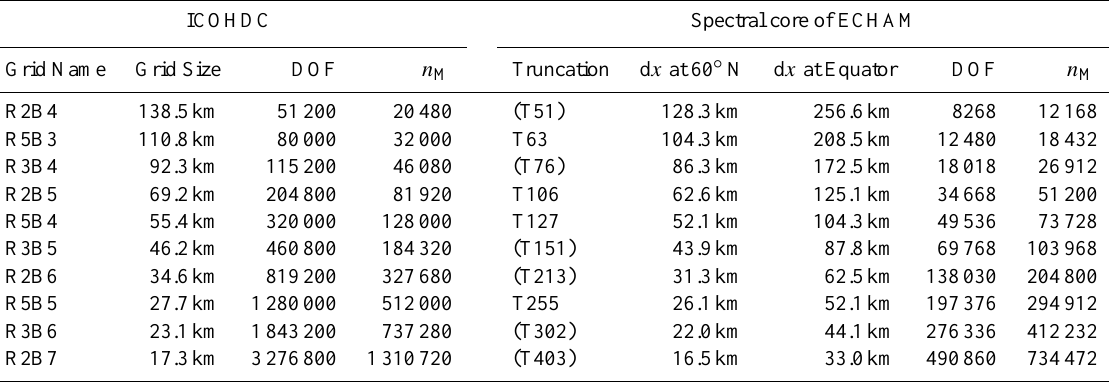
Table 2. Resolutions of the ICOHDC and the spectral core of ECHAM that produce similar results in the baroclinic wave test case. The grid size given in the left half of the table is the average distance between mass points on the triangular grids. “d x ” in the right half of the table refers to the zonal spacing of the Gauss grid. The degrees of freedom (DOF) and the total number of mass points n M are included in the table for the discussion in Appendix C. The DOF of the ICOHDC is defined as the total number of velocity and mass (temperature) points on one vertical level. The DOF of the spectral core is defined as the total number of spectral coefficients of vorticity, divergence, and temperature on one vertical level. The n M in the spectral model is that of the corresponding Gauss